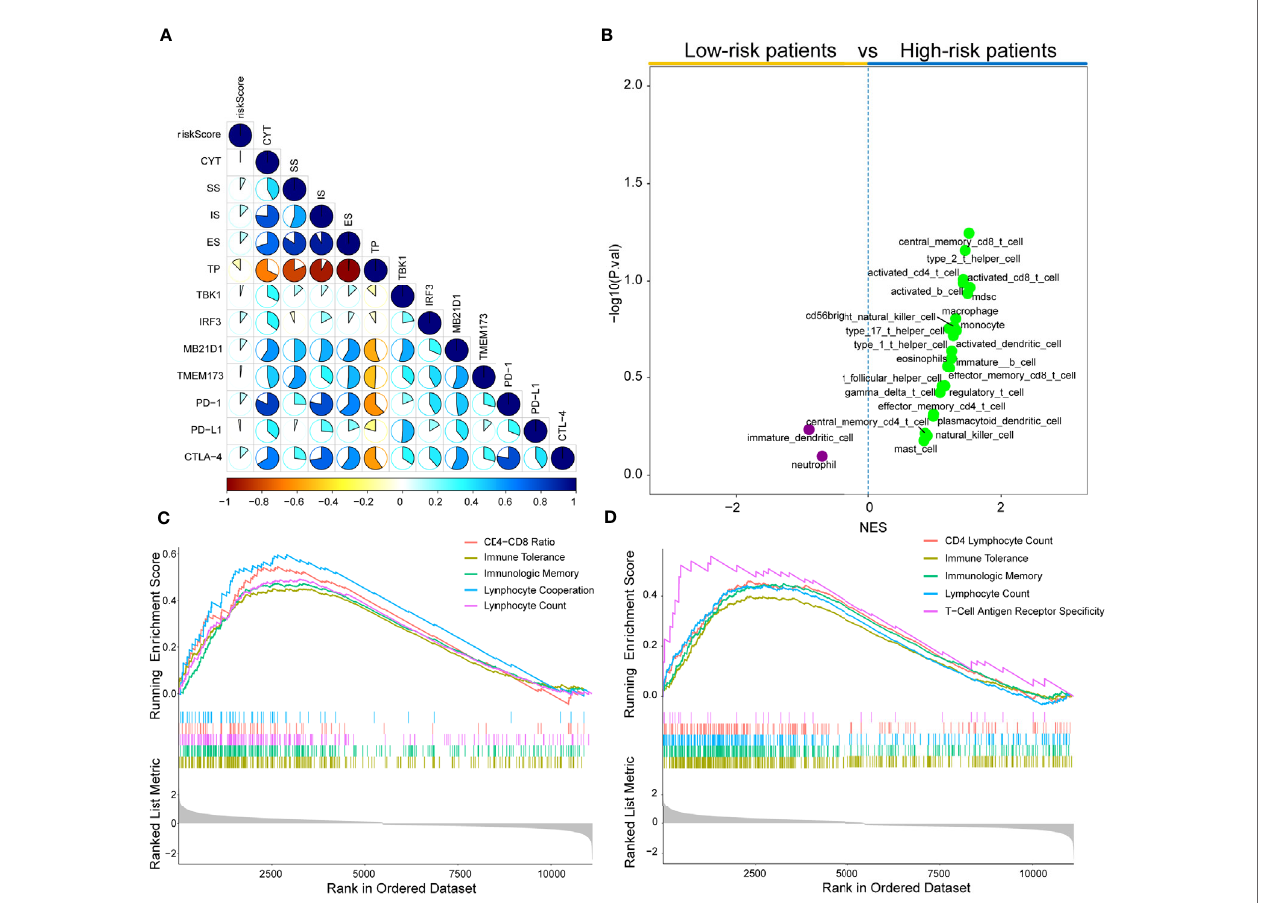
FIGURE 8 | Immune landscape of risk score in the TCGA cohort. (A) Correlations between risk score, levels of expression of PD-L1, CYT, TBK1, IRF3, MB21D1, CTLA-4, PD-1, and TMEM173, immune score, stromal score, ESTINATE score, and tumor purity in the TCGA cohort. (B) Volcano plots for immune cell sub-population enrichment in high- and low-risk patients according to NES scores from ssGSEA. (C) Gene set enrichment analyses described the MeSH terms correlated with risk score using gendoo term in the TCGA cohort. (D) Gene set enrichment analysis described the MeSH terms correlated with the risk score using gene2pubmed term in the TCGA